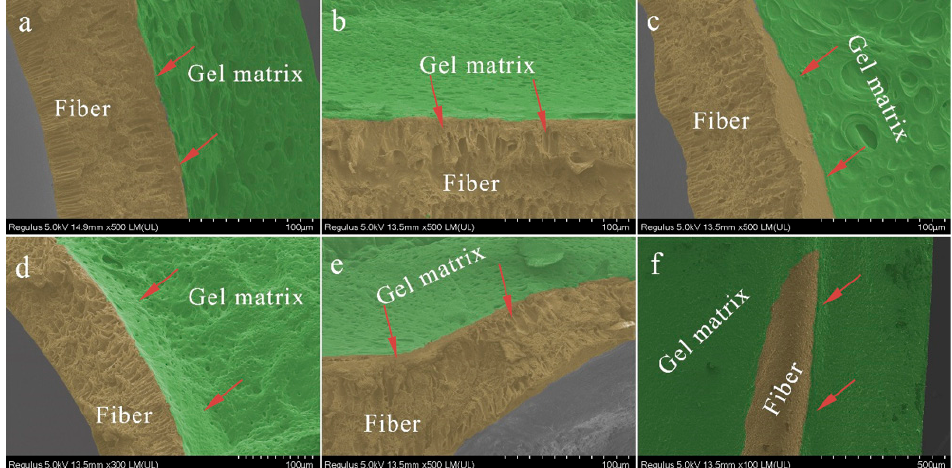
Figure 2. SEM morphology of interface morphology between the gel matrix and hollow fibers.